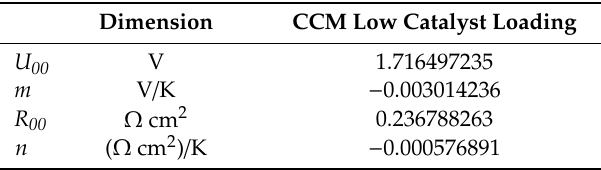
Table 3. Parameters for a linear cell